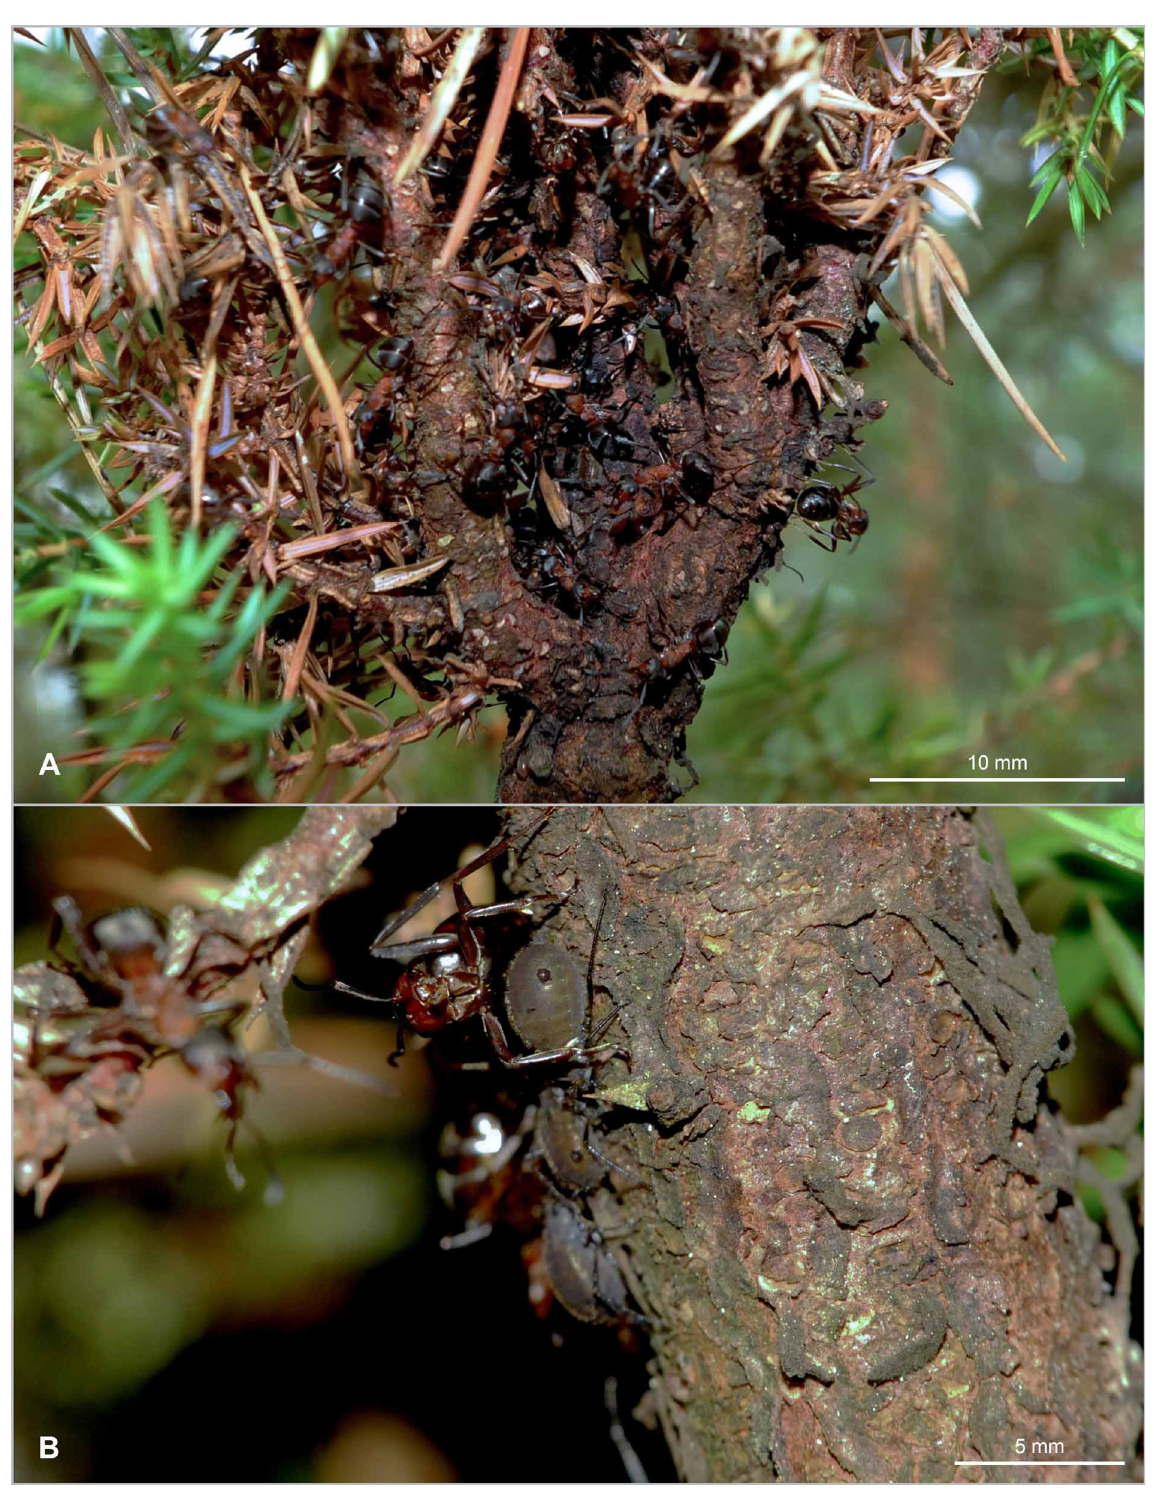
Fig. 111. Cinara (Cupressobium) smolandiae Danielsson & Carter, 1993. Colony in Gymnosporangium - induced wound on Juniperus communis , attended by Formica polyctena Förster,